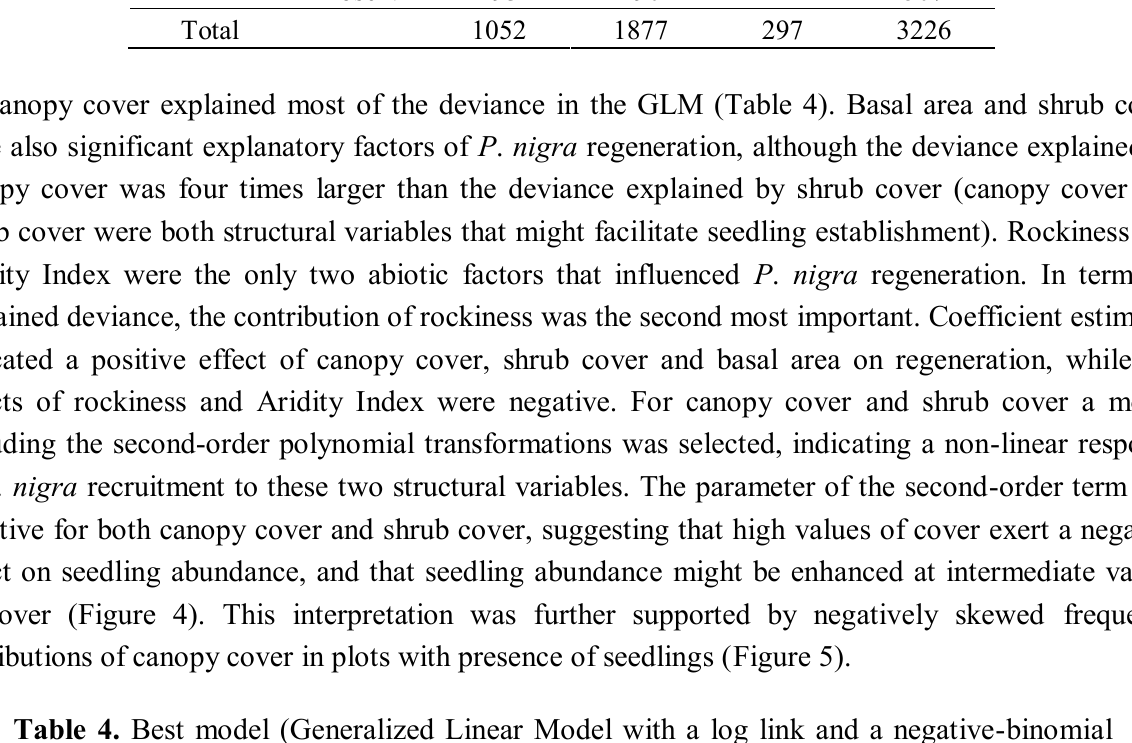
Table 4. Best model (Generalized Linear Model with a log link and a negative-binomial distribution) of Pinus nigra subsp. salzmannii seedling abundance estimated by a stepwise procedure. The selected transformations poly (2) are polynomial second-order transformations, degree of freedom ( df ), residual degree of freedom (Resid. df ), residual deviance (Resid. Dev.) and probabilities χ 2 tests of the effect of the variable are given. Model deviance = 0.064.